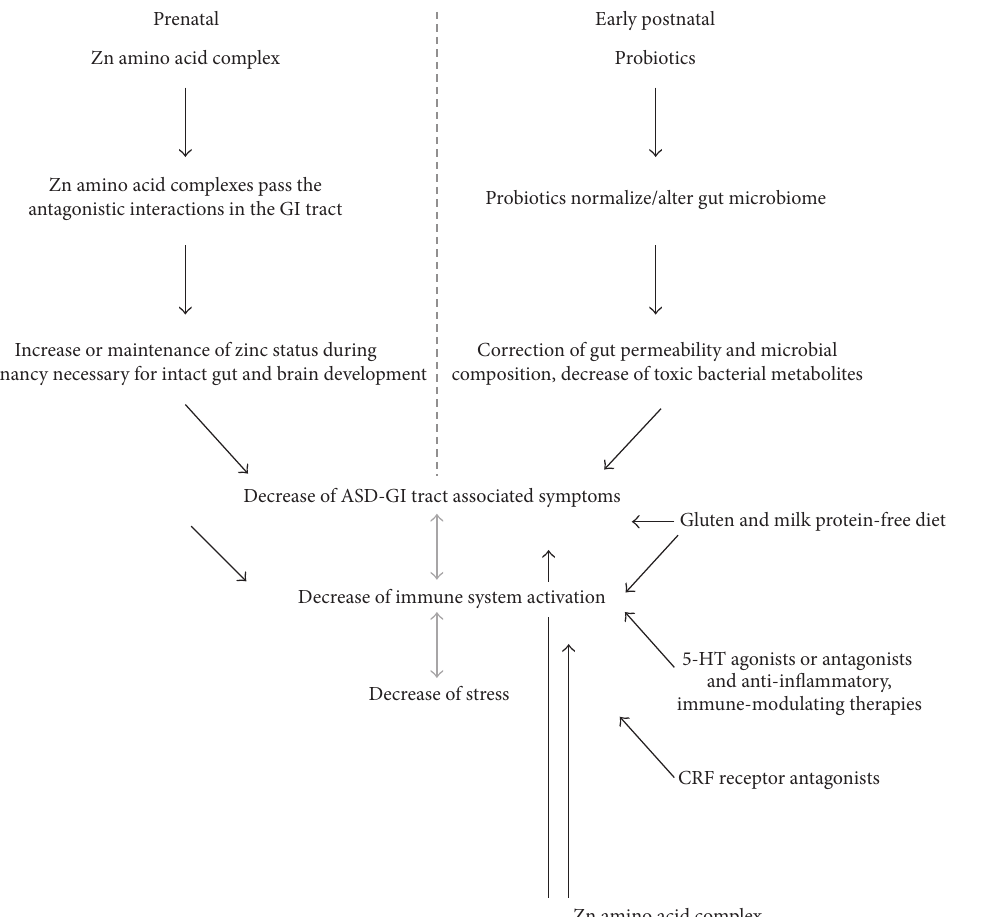
Figure 4: Prevention and treatment strategies. Zinc amino acid complexes might be an effective source to overcome the negative effects of dietary constituents and nutrients in prenatal supplements and help women to maintain adequate zinc status (prenatal prevention, left panel). Zinc supplementation might also be useful in young children with ASD helping to overcome some impairments associated with acute zinc deficiency (diarrhea, impaired immune function, and neurosensory deficits) (postnatal treatment, right panel). Furthermore, young children with ASD might benefit from probiotic therapy that may correct gut permeability, alter microbial composition, reduce burden of bacterial waste products and metabolites, and thereby ameliorate ASD symptoms. Additionally, a gluten and milk protein-free diet was proposed to potentially be beneficial for individuals with ASD. 5-HT signaling may mediate both innate and adaptive responses in the immune system and 5-HT signaling important in the brain and in the GI tract; 5-HT receptors are expressed. Thus, 5-HT3 antagonists or 5-HT4 agonists may have a modulatory effect. Moreover, therapeutics used to treat inflammatory events caused by abnormal GI function (anti-inflammatory and immune-modulating therapies) might be beneficial. Stress is linked to abnormalities in the GI tract and mediated by, among others, the corticotropin-releasing factor (CRF) system on molecular level. The use of CRF receptor antagonists might therefore provide new treatment